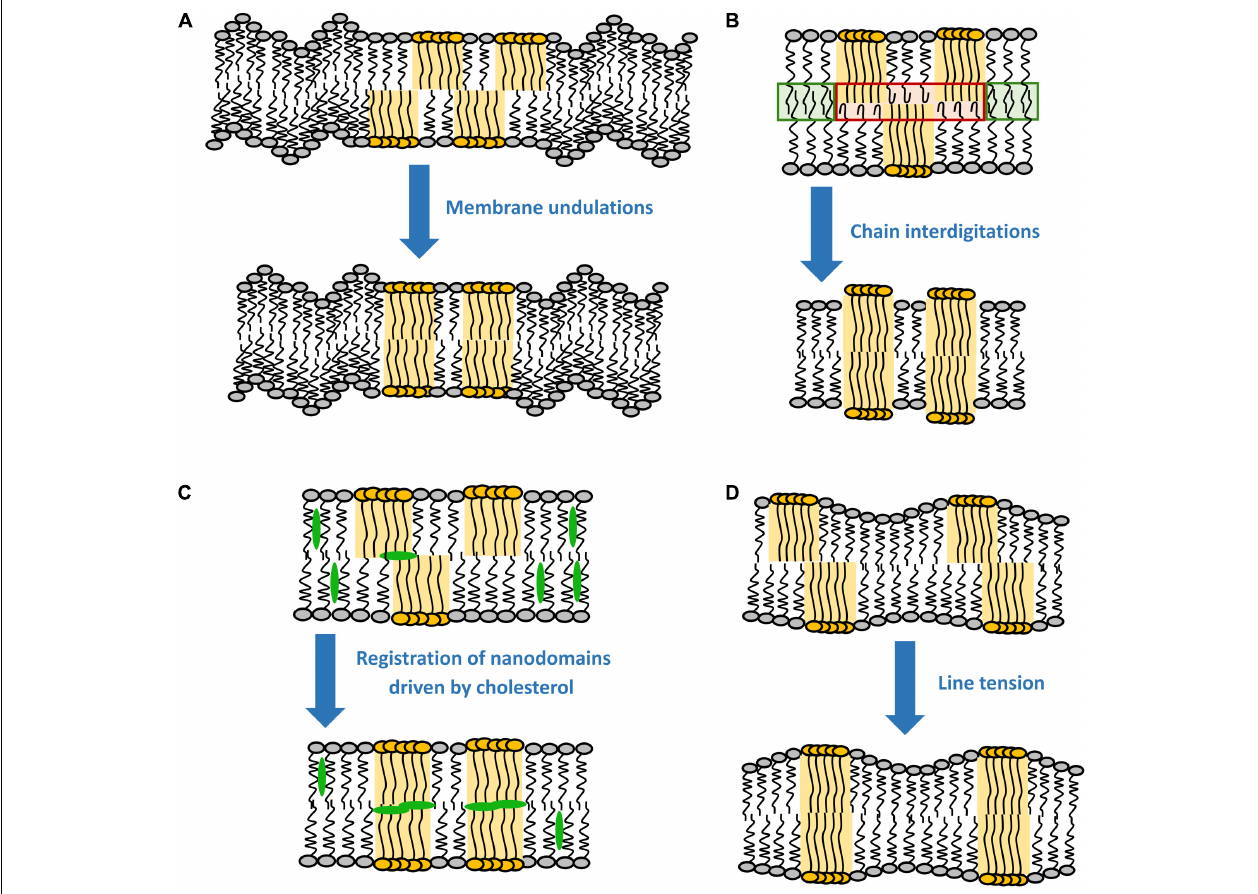
FIGURE 1 | Most probable driving forces for the registration of nanodomains. (A) Membrane undulations, (B) chain interdigitations, (C) registration of nanodomains by cholesterol, and (D) line tension.